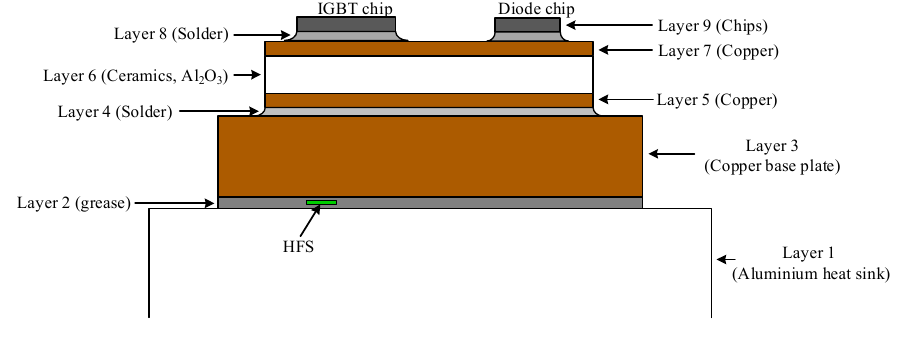
Figure 4. Cross ‐ section of the model. Figure 4. Cross-section of the model. Table 1. Properties of the materials in the